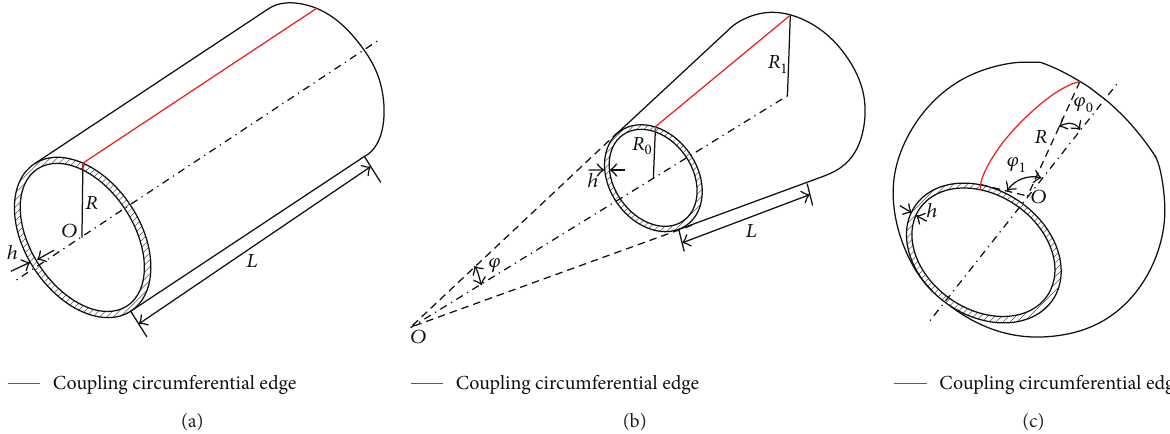
Figure 3: The sketches of the closed shells with coupling circumferential edge: (a) cylindrical shell; (b) conical shell; (c) spherical shell.